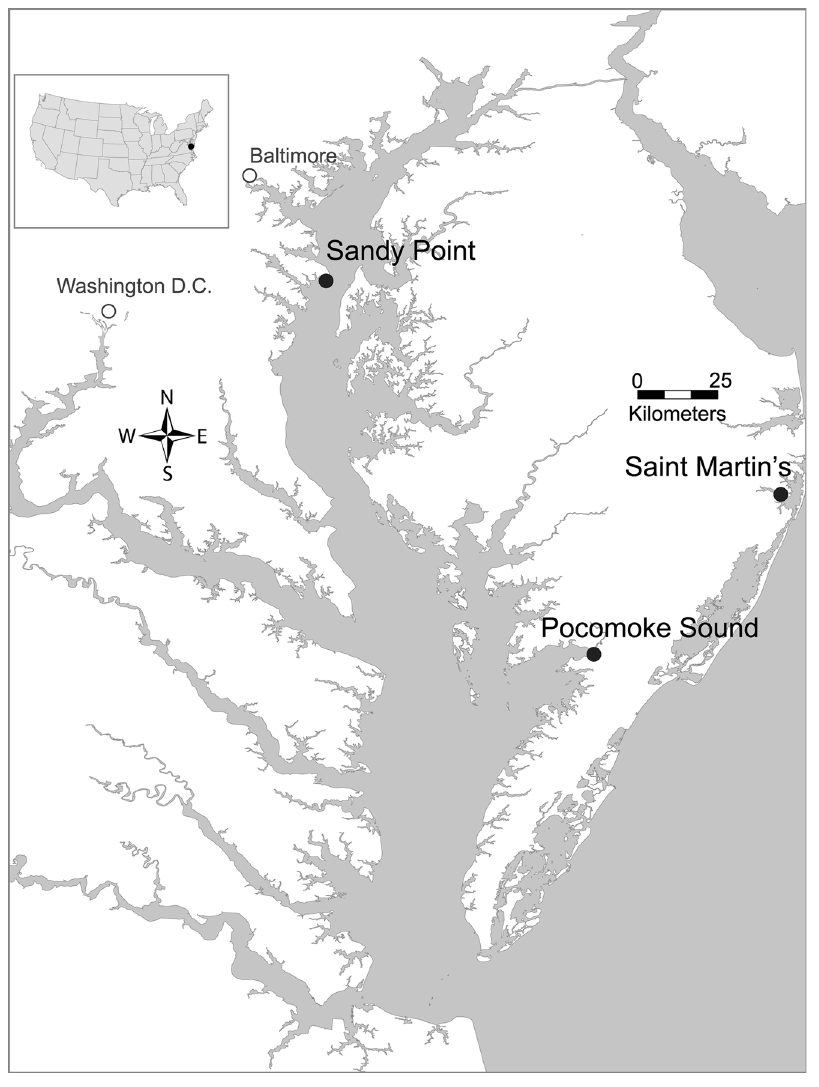
Figure 1. Sampling sites in Chesapeake Bay and Maryland Coastal Bays. (Tracey Saxby, Kate Boicourt, Integration and Application Network, University of Maryland Center for Environmental Science (ian.umces.edu/imagelibrary/displayimage-127-5815.html).